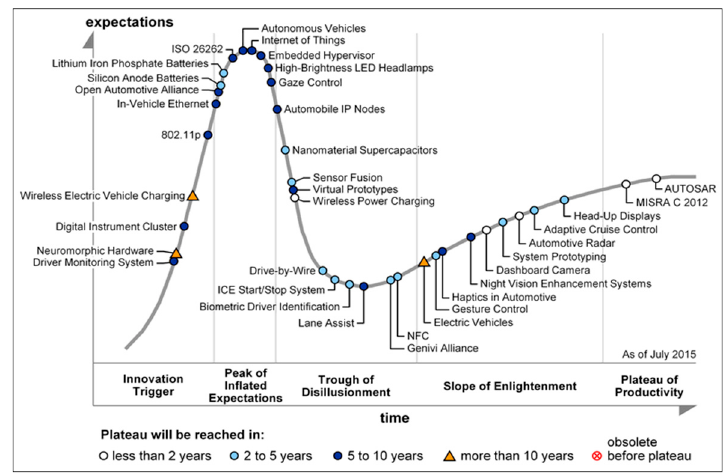
Figure 14. Automotive executive survey. Reproduced with permission from KPMG Netherlands, 2019.